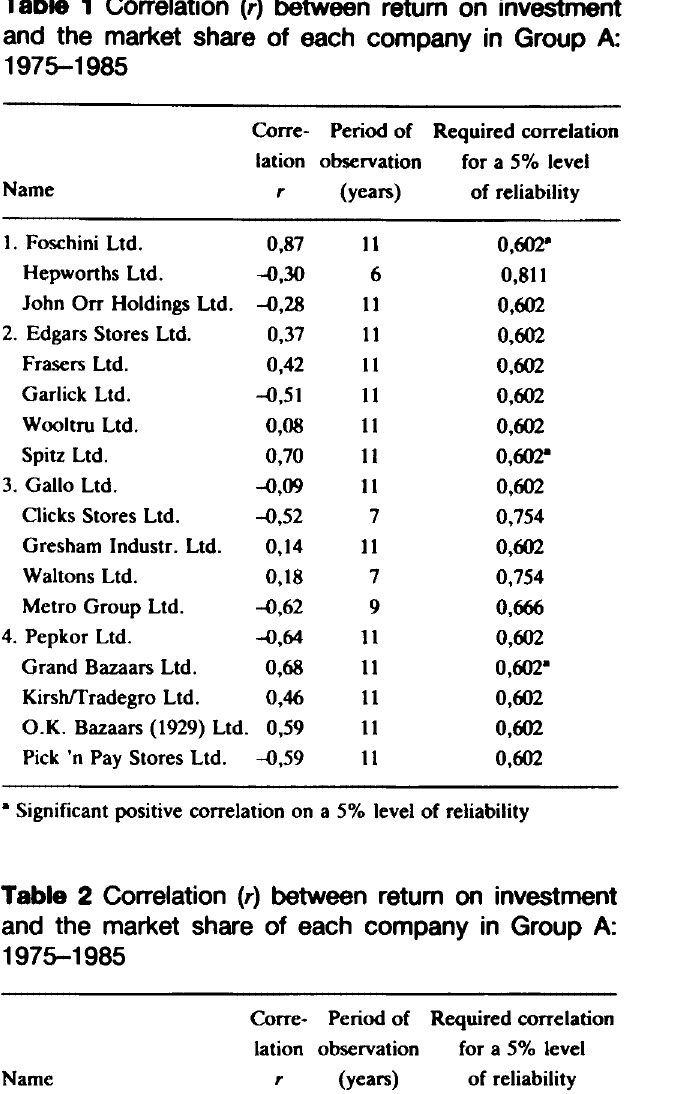
Table 2 Correlation (r) between return on investment and the market share of each company in Group A: 1975-1985